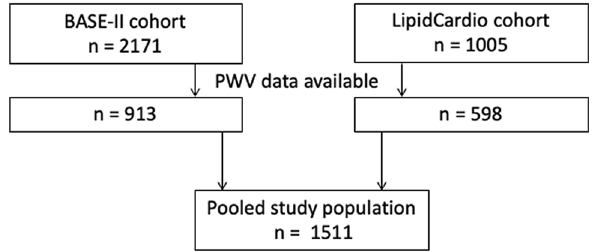
Figure 1. Flow chart of sample selection. In both cohorts only in random subsamples pulse wave velocity (PWV) measurements had been performed (LipidCardio N = 598 out of total 1005, and BASE-II N = 913 out of total 2171), resulting in a sample size of